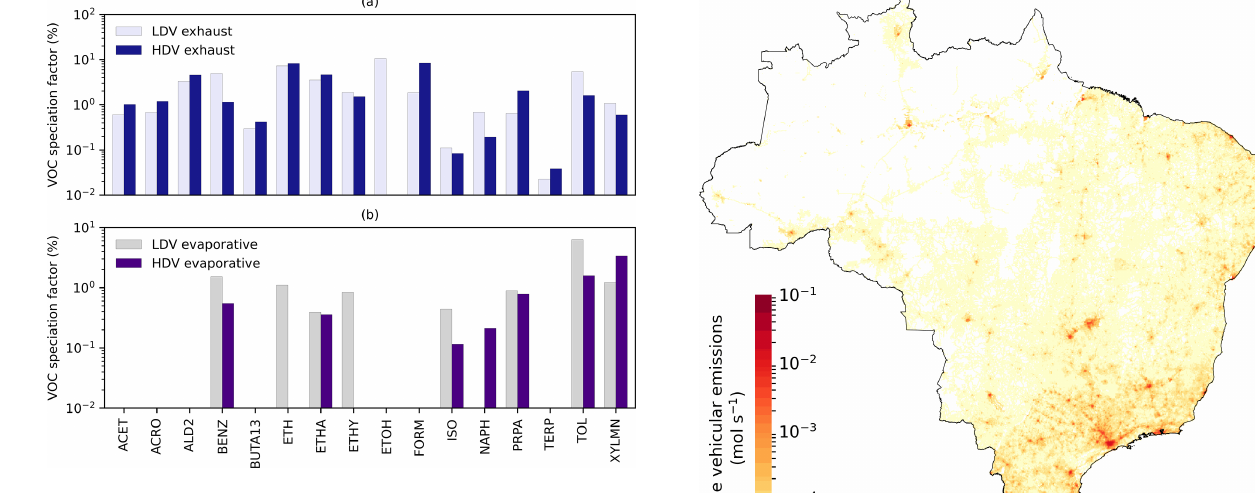
Figure 5. VOC chemical speciation factors for (a) exhaust and (b) evaporative emissions from light and heavy vehicles. Data derived